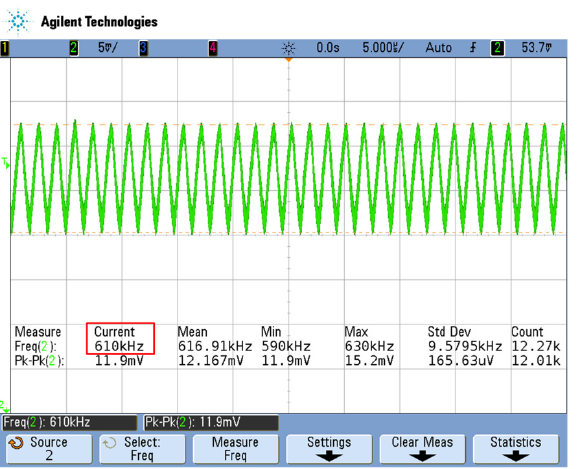
Figure 9. Test waveform diagram of the output signal of AD835 mixer .